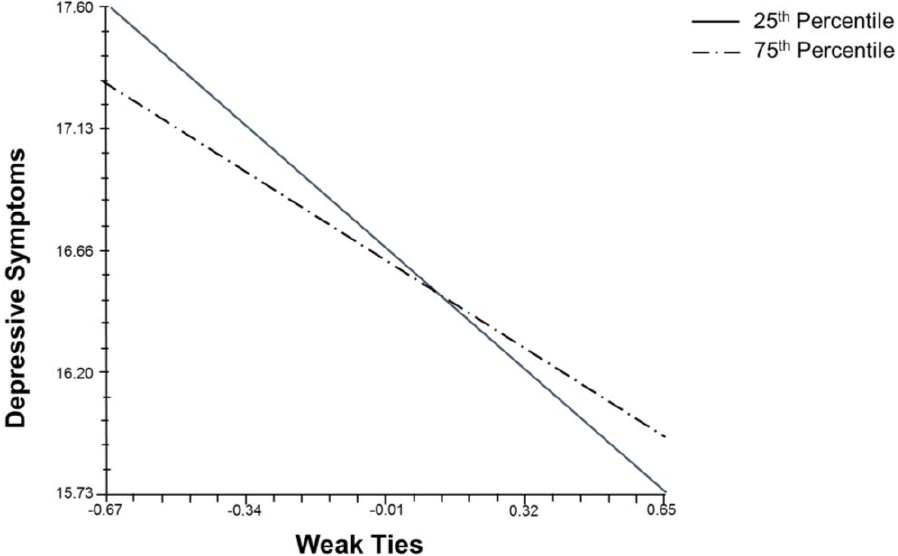
Figure 1. Proportion of foreigners.